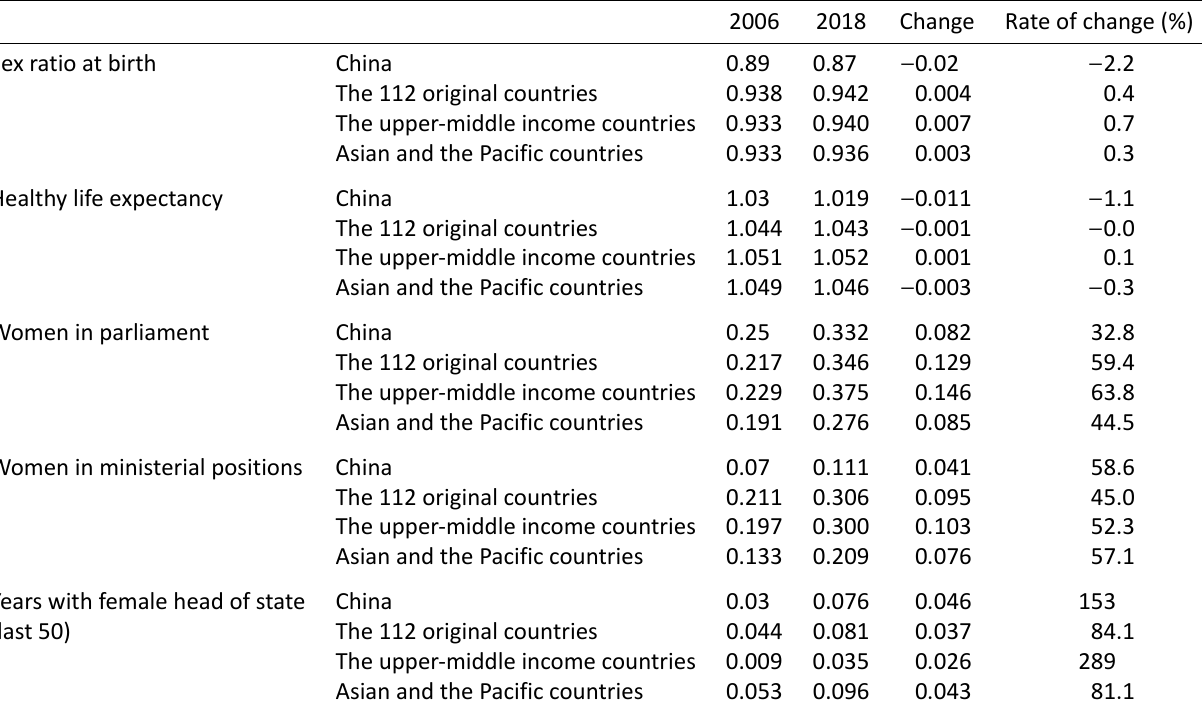
Table 4. Comparison of the scores on health and survival and political